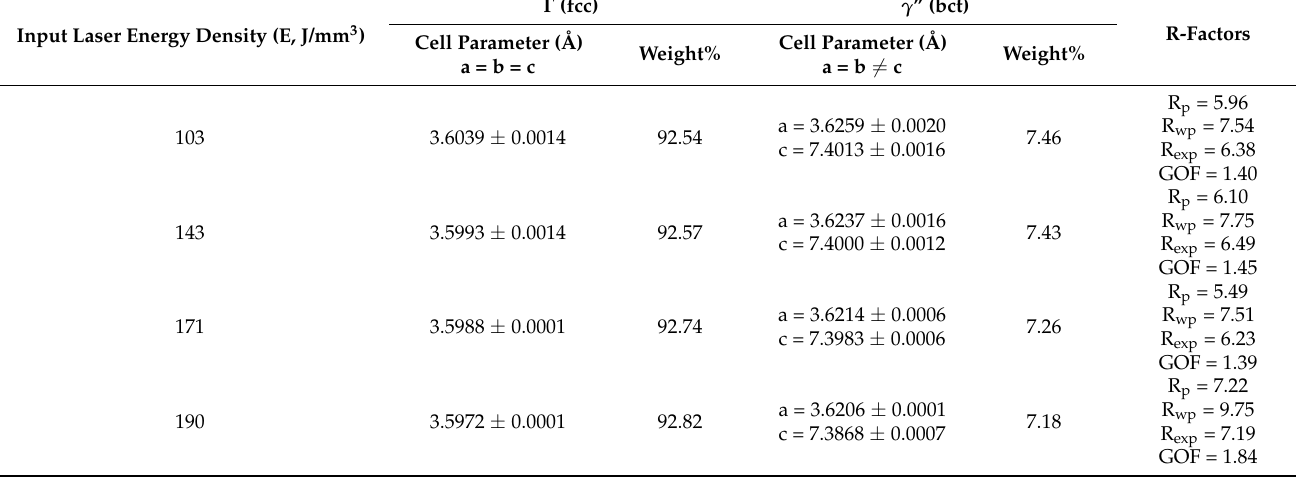
Table 4. Lattice constant values at different E based on Rietveld